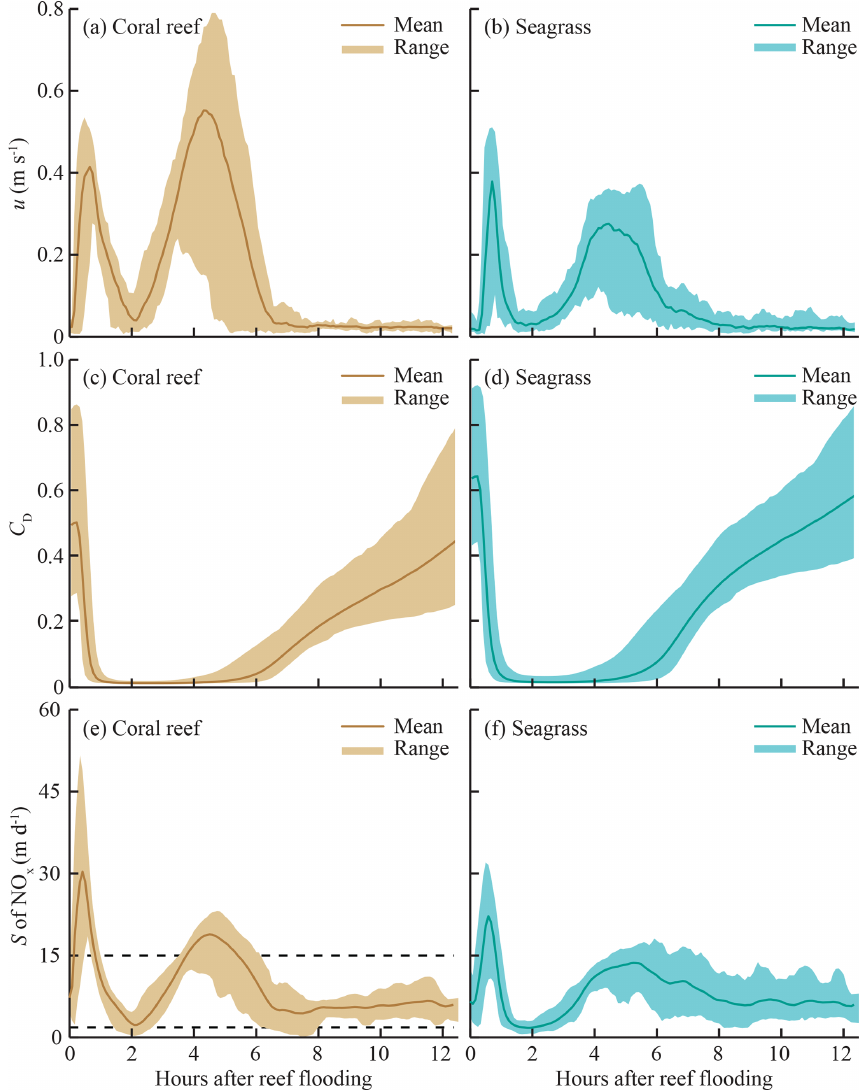
Figure 5. Tidal phase-averages of flow speed u , drag coefficient C D , and mass-transfer velocity S for nitrate (NO x ) in coral- and seagrass- dominated zones. Phase-averages are the mean of all measurements occurring at the same point in the tidal cycle (e.g., mean of all S at high tide), and the range represents conditions during spring and neap tidal cycles. Hydrodynamic data are from April 2014. Dashed lines in panel (e) indicate upper and lower limits of S measured from previous studies of reef communities reviewed by Atkinson and Falter